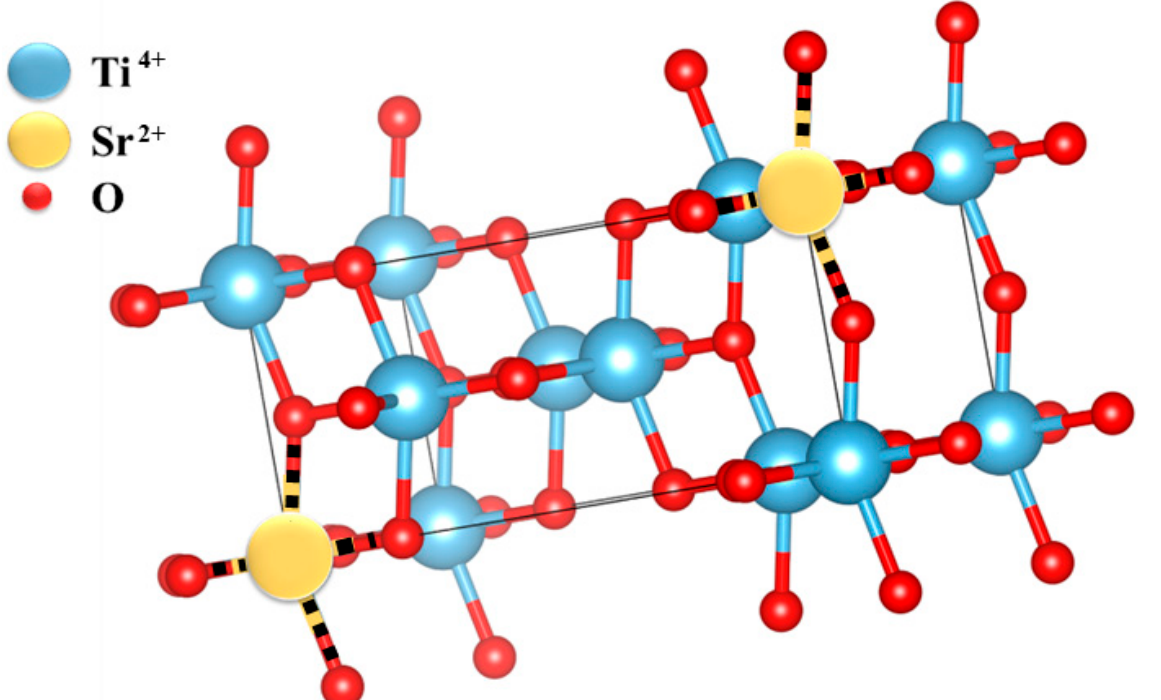
Figure 3. Crystal structure of Sr-doped TiO 2 nanoparticles.